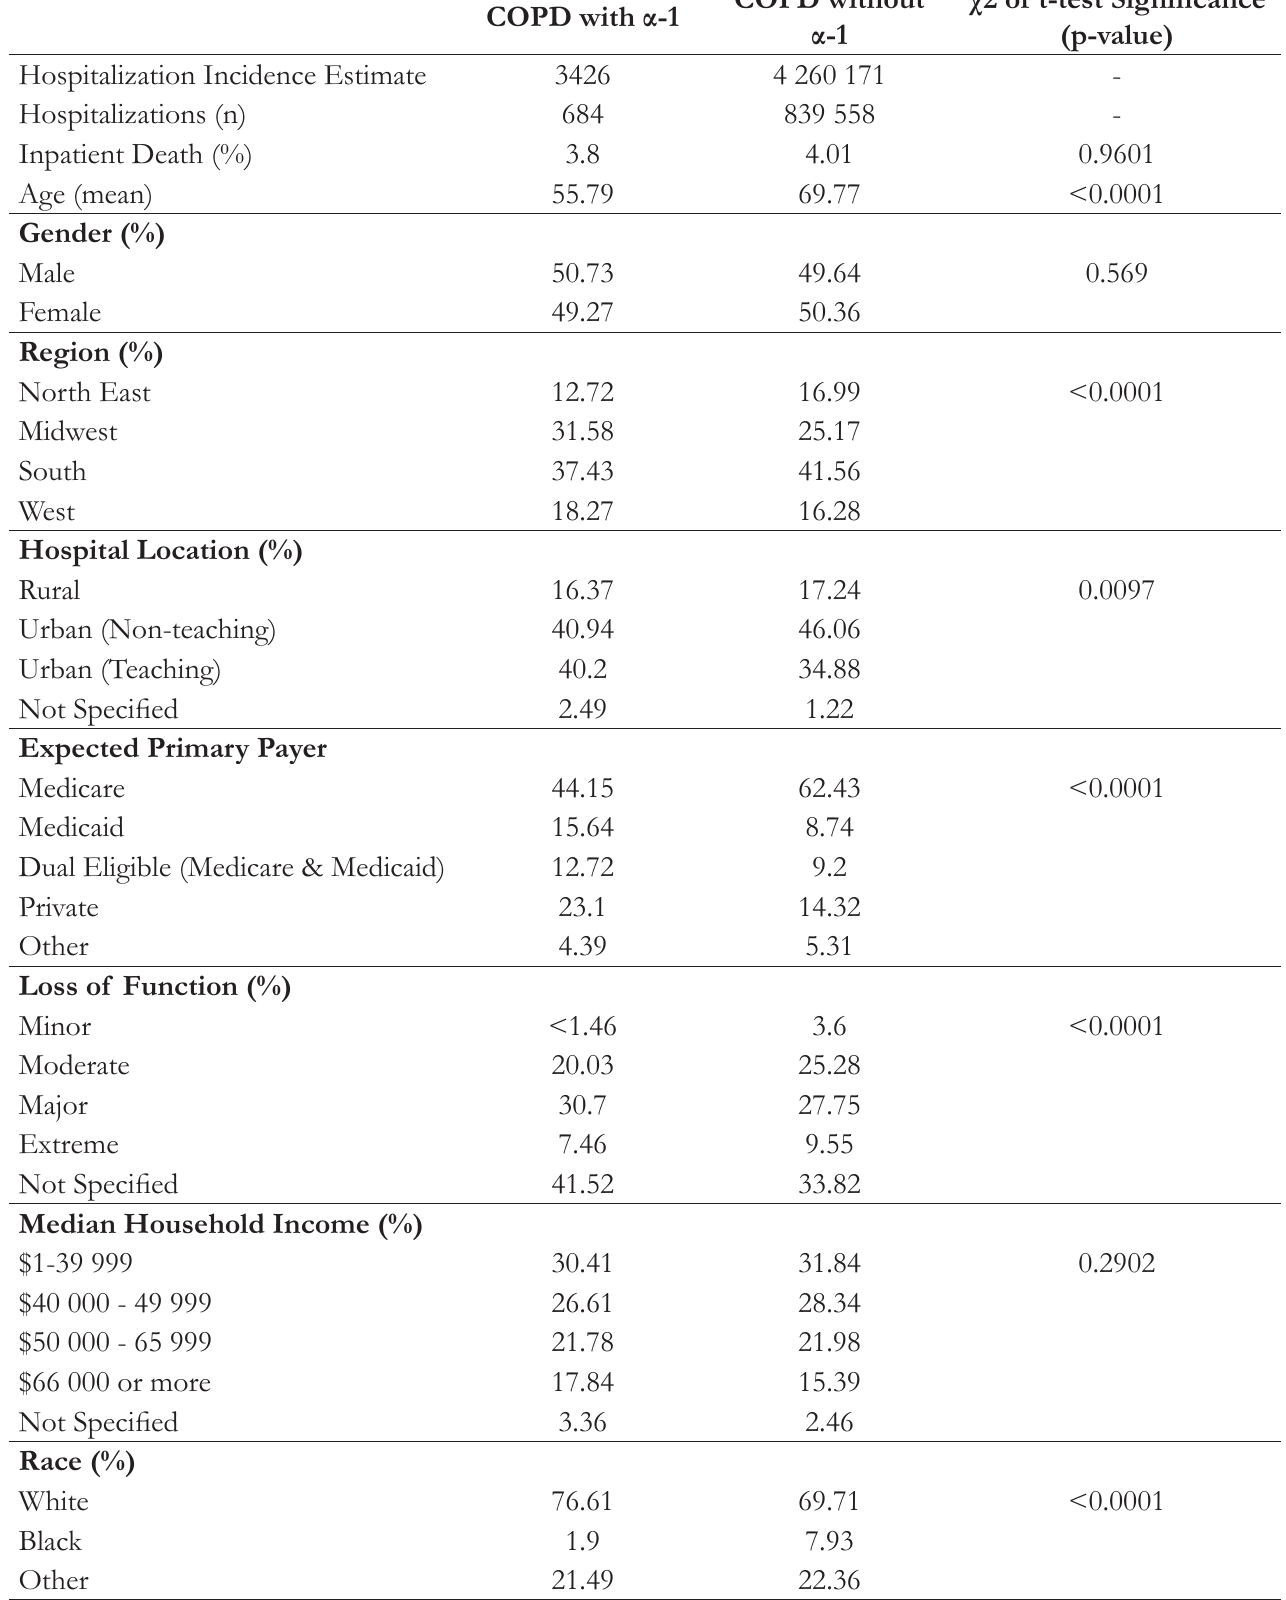
Table 1. COPD Population Characteristics by Alpha-1 Antitrypsin Deficiency Diagnosis